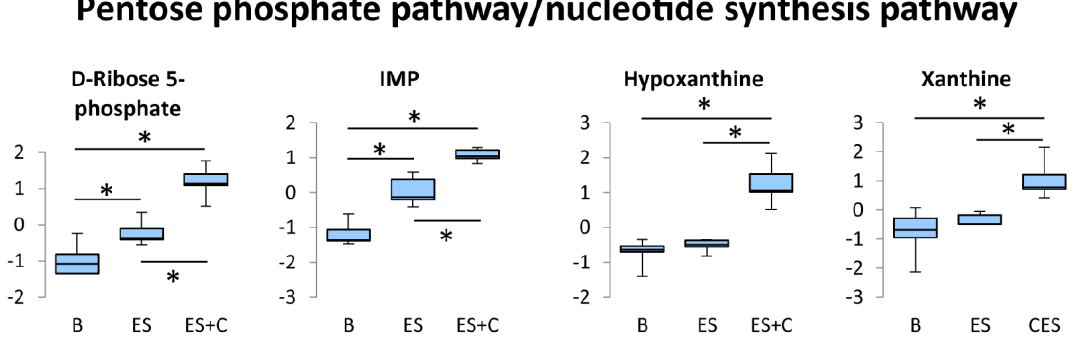
Figure 4. Box plots of the concentration variations of significantly altered metabolites in the pentose phosphate pathway/nucleotide synthesis pathway. Y axes are represented as normalized intensity. The boxes range from the 25% to the 75% percentiles. Medians are indicated by horizontal lines within each box. The ends of the whiskers represent the maximum and minimum of the data. * One-way ANOVA with Tukey’s post hoc test indicates a significant difference (false discovery rates (FDR) < 0.05) between groups.